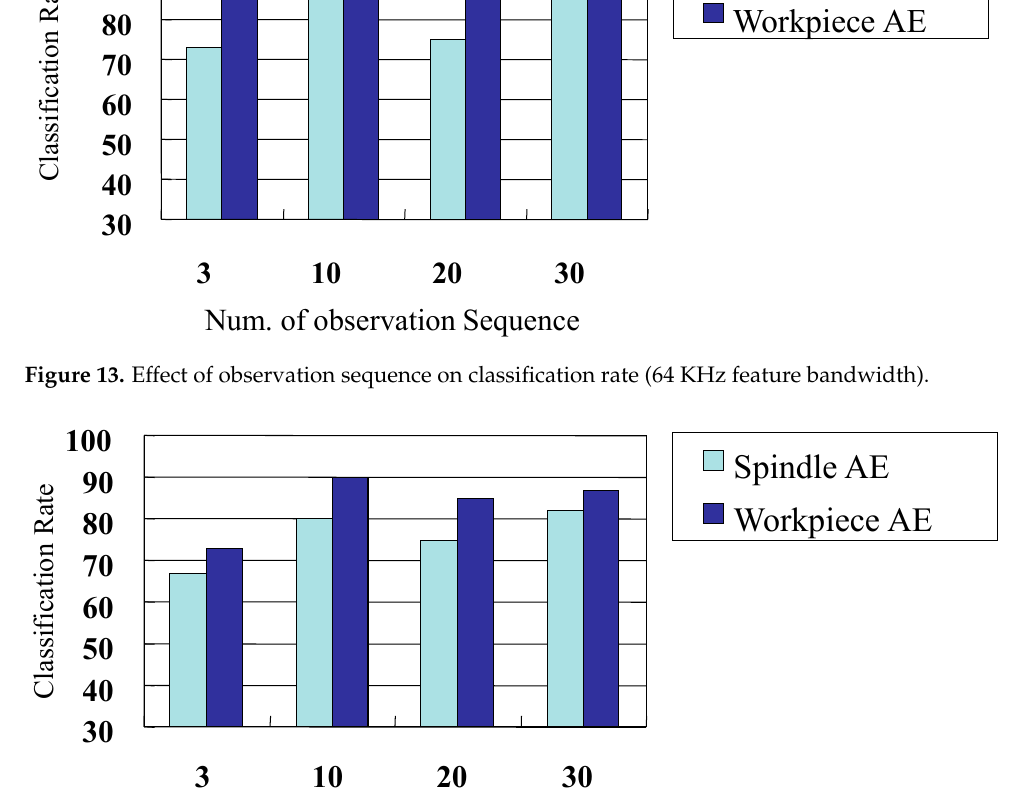
Figure 14. Effect of observation sequence on classification rate (32 KHz feature bandwidth).